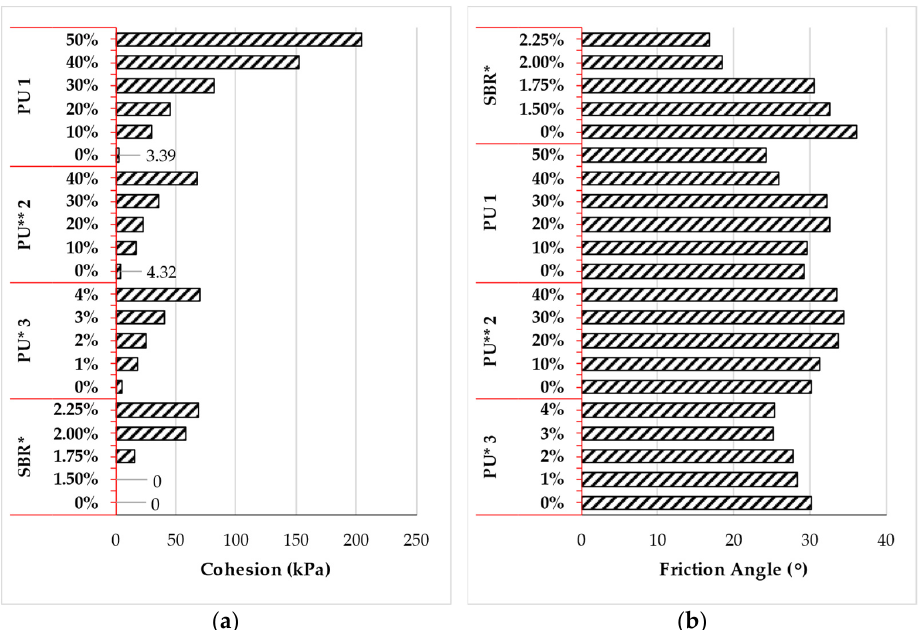
Figure 8. Variation in the shear strength parameter of cohesionless soil with polymer concentration: ( a ) Cohesion; ( b ) Frictional angle (* indicates polymer concentration as a % of dry weight of soil and ** as a % of weight of water). Note: these figures were created with data obtained from [114,116,130,160].